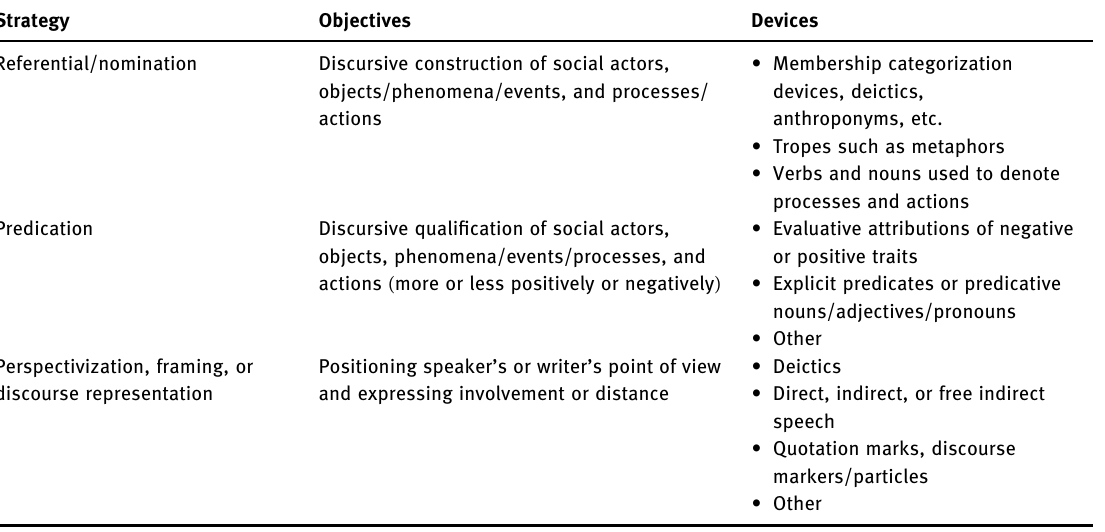
Table 1: Discursive strategies ( adapted from Reisigl and Wodak 2009, 104 )